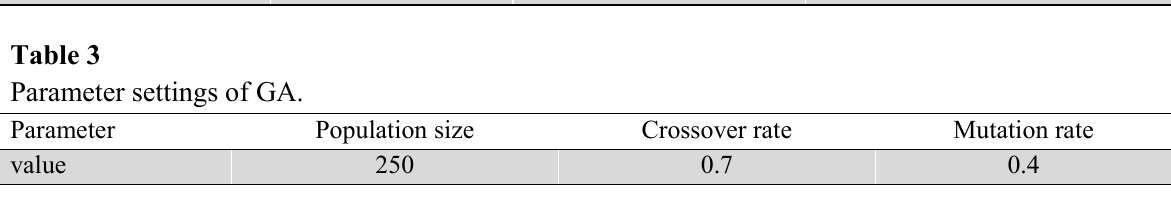
Average relative gaps and CPU time for small-sized test problems. Data